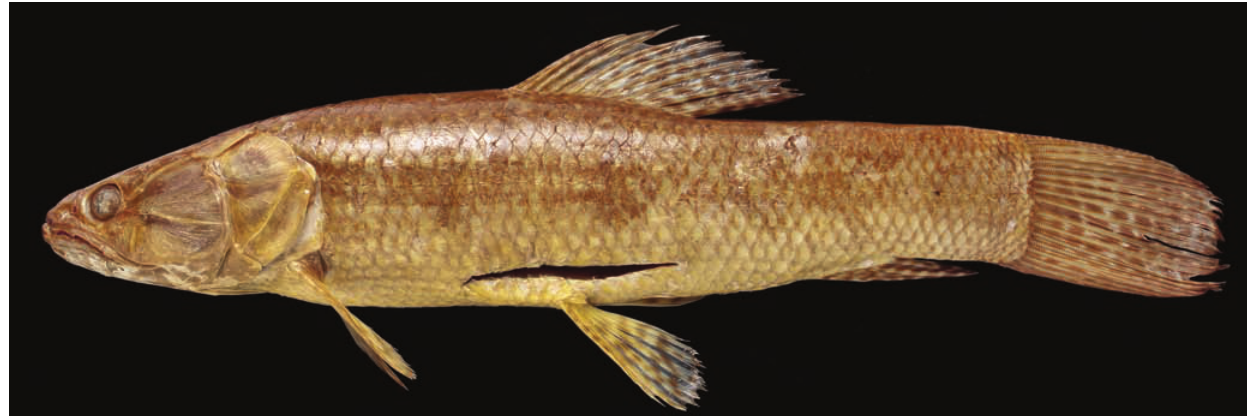
Fig. 1. Hoplias microlepis (lectotype of Macrodon microlepis ), BMNH 1864.1.26.221, 269.7 mm SL, Chagres River,